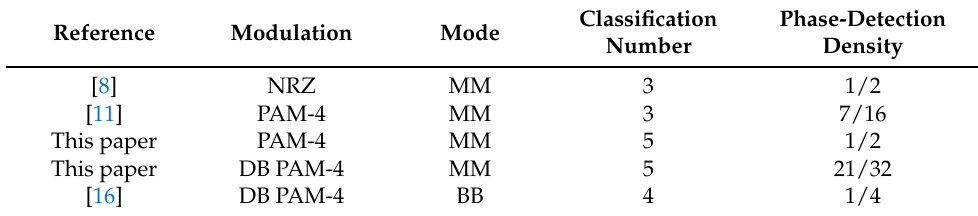
Table 2. Phase-detection density comparison.